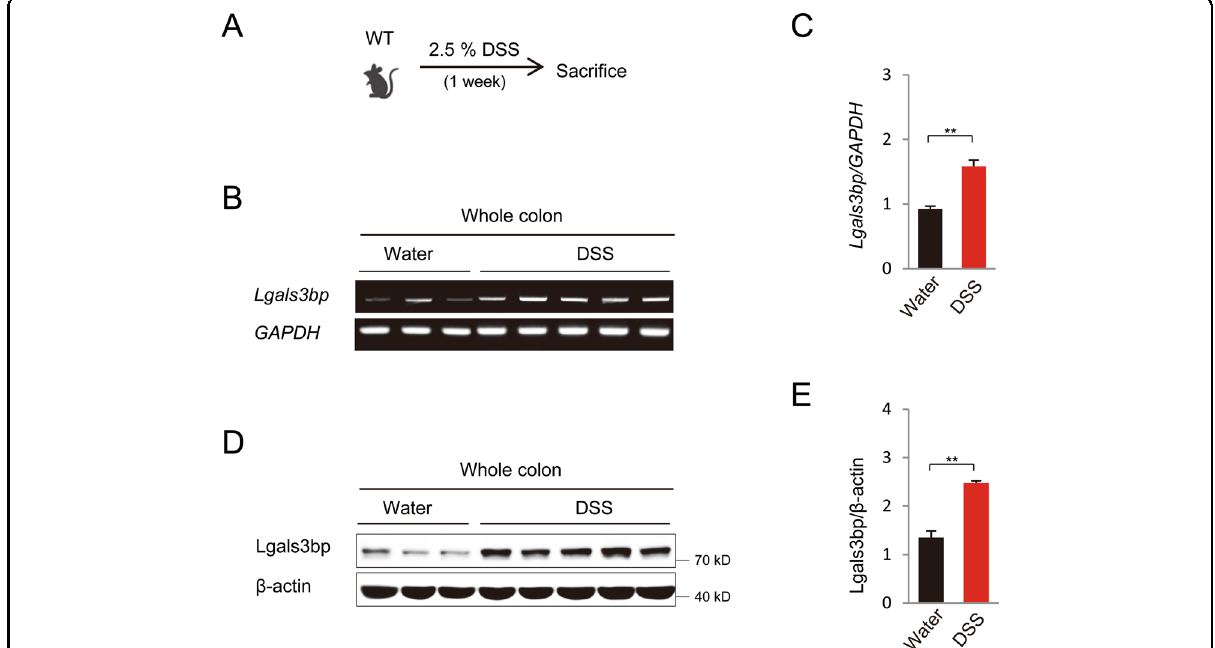
Fig. 1 Elevated Lgals3bp expression in the colon of DSS-induced colitis mice. A Scheme of DSS-induced colitis in WT mice. Mice ( n = 5) were administrated 2.5% DSS in drinking water for 7 days and sacri fi ced on day 7. Waterfed mice ( n = 3) served as control; colon tissue was collected. B , C RNA was isolated from whole colons, and Lgals3bp and GAPDH expression was analyzed using RT-PCR ( B ) and RT-qPCR ( C ). D Protein extracts of the whole colon from WT and Lgals3bp − / − mice were analyzed for the expression of Lgals3bp and β -actin proteins via western blotting. E Densitometric analysis of band intensities of western blots is shown in ( D ). Data are presented as means ± SEM values. ** p < 0.01; *** p <